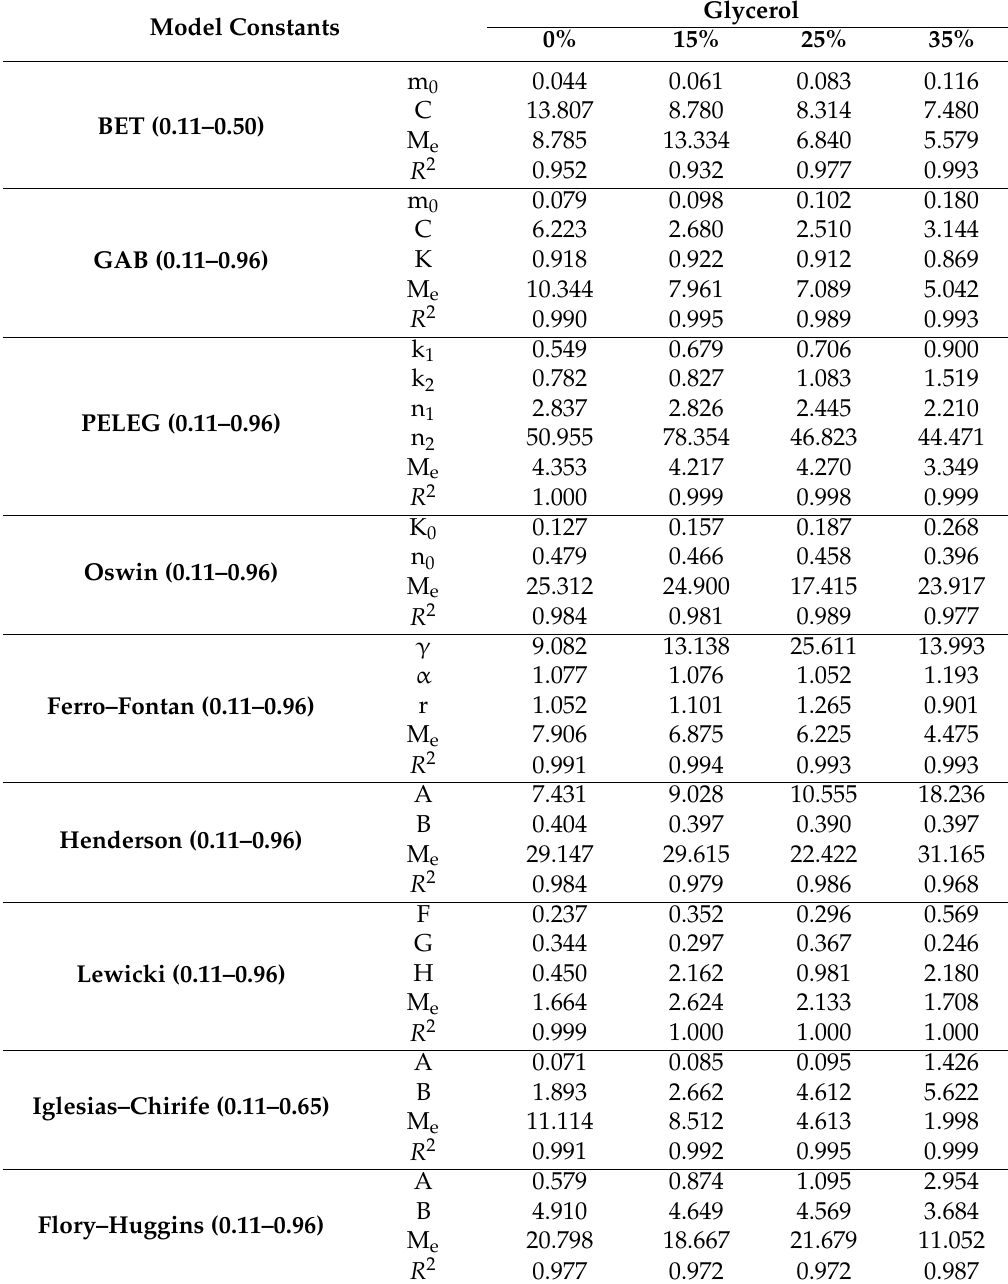
Table 3. Estimated model constants and values of coefficients and mean relative percentage deviation moduli for different pea starch films at 15 ˝